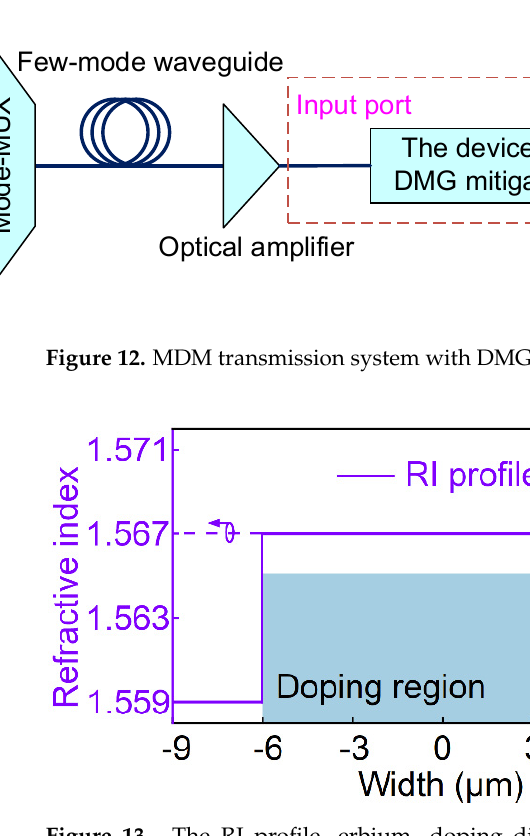
Figure 13. The RI profile, erbium − doping distribution and concentration of the few − mode erbium − doped polymer waveguide.